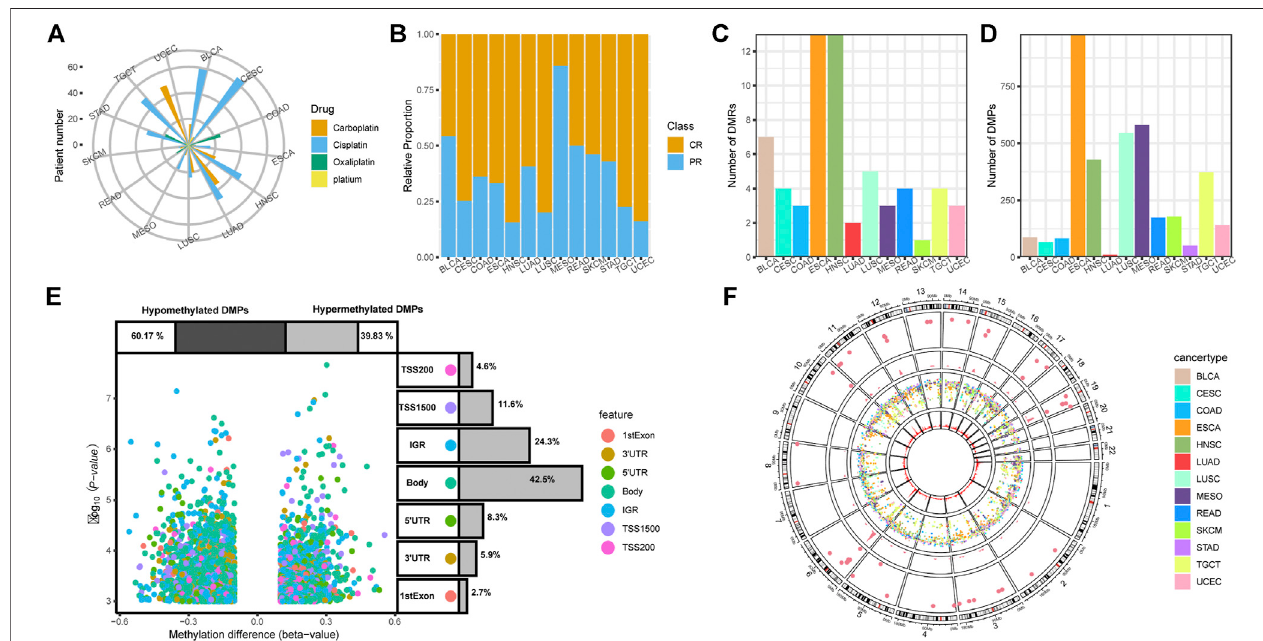
FIGURE 1 | Clinical information and DNA methylation patterns associated with platinum response. (A) Clinical application of platinum agents in 13 TCGA cancer types. (B) Theplatinum-sensitivegroup(CR)/platinum-resistantgroup(PR)relativeproportionof13cancertypes. (C) Numberofdifferentiallymethylatedregions(DMRs) in each cancer type. (D) Number of differentially methylated positions (DMPs) in each cancer type. (E) Volcano plots of DMPs with annotation of the methylation probe feature. (F) Rainfall and density plots of all DMRs and DMPs.